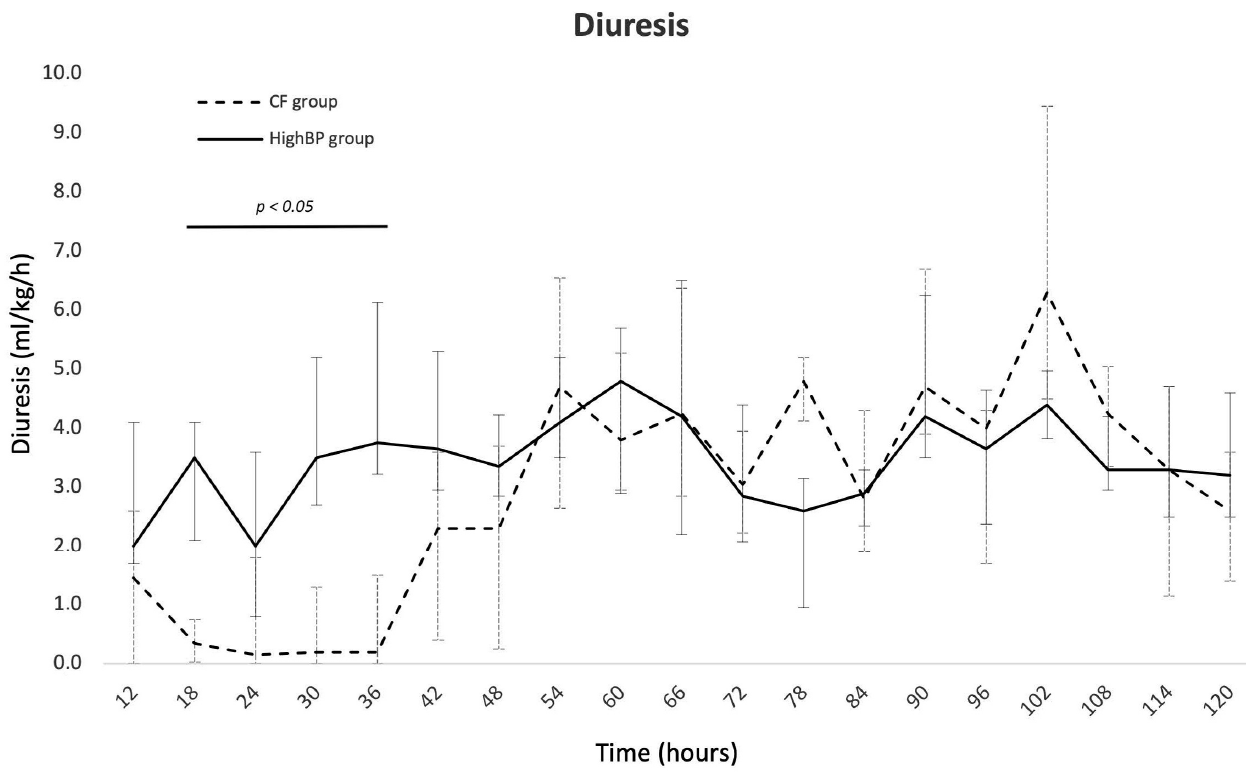
Figure 3. Urine output of recipient twins with cardiac failure (CF group) and with high systolic blood pressure alone (HighBP group). Data are presented as median values with 1st and 3rd